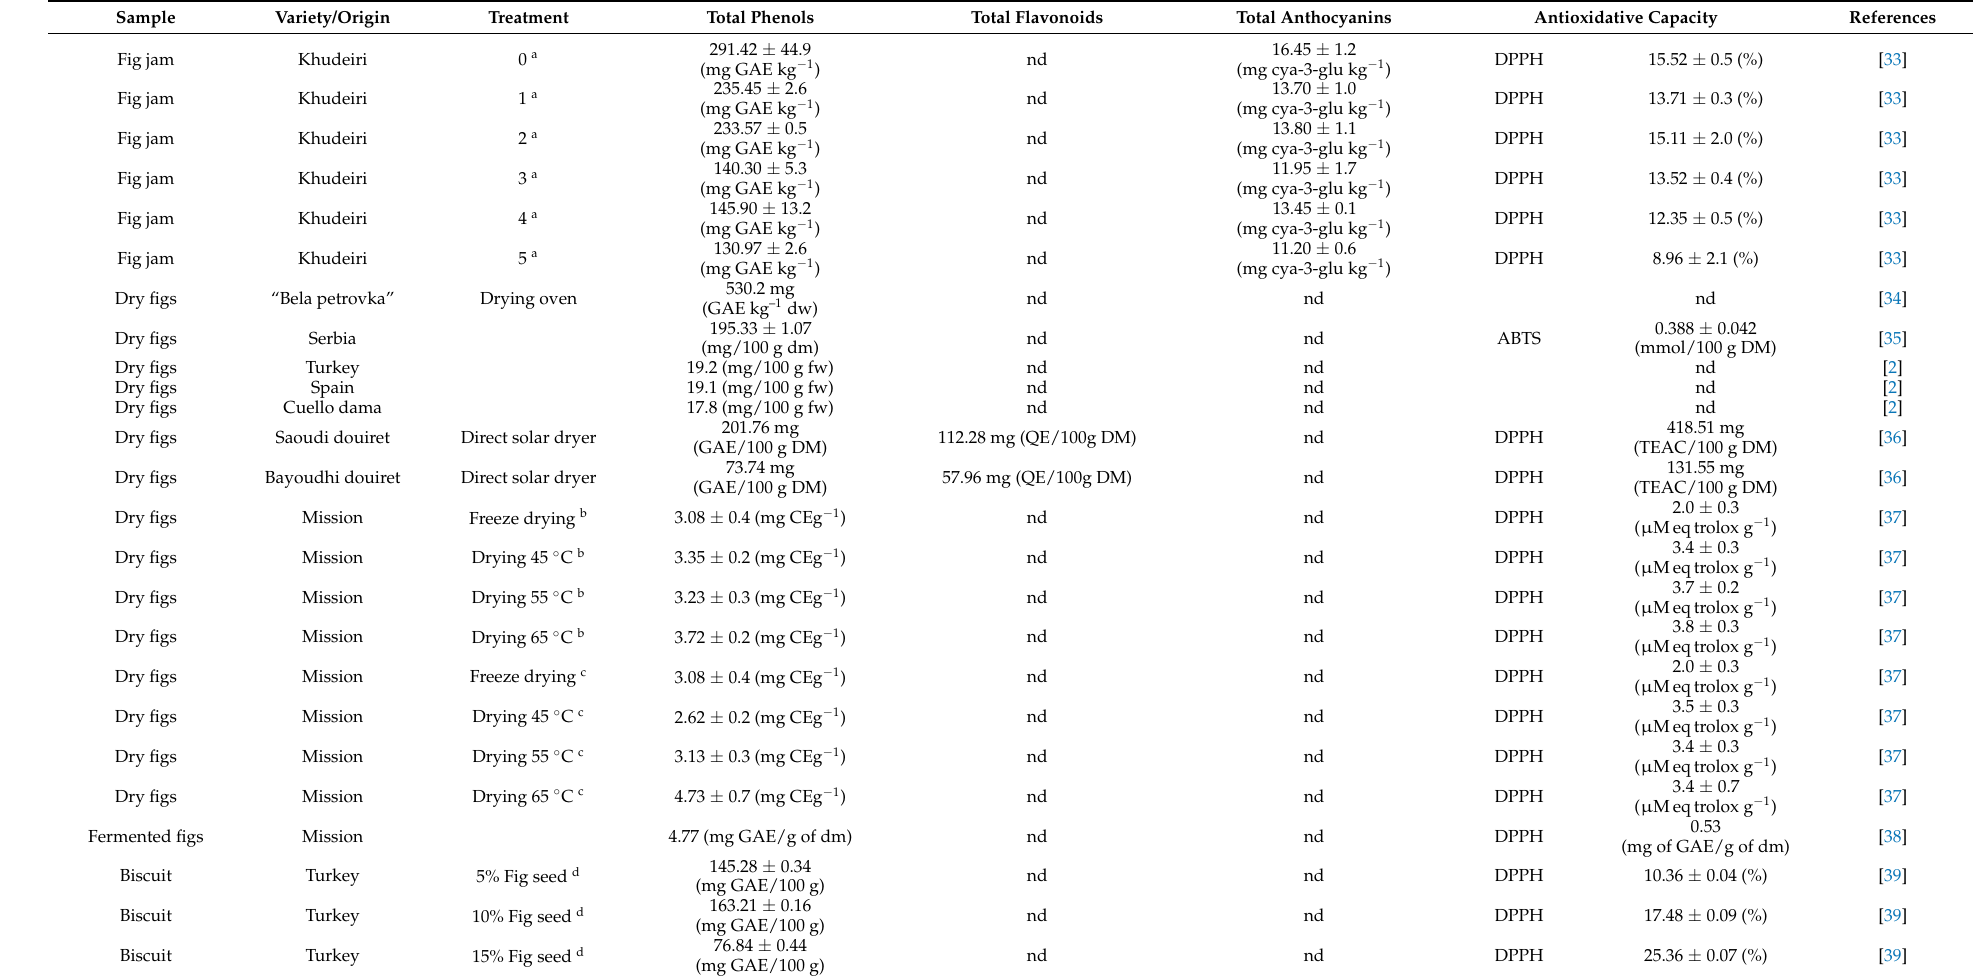
Table 2. Fig cultivar, total phenols, total flavonols and total anthocyanins, and the antioxidant capacity of the reported fig-based